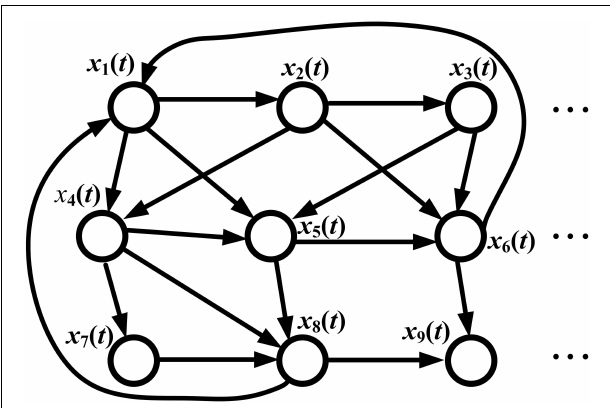
FIGURE 2 | Information flow in a GRN. x i ( t ) denotes the gene expression of the i th gene. Since the gene regulation is directional, the graph of the GRN is a directed graph (digraph). The signal processing model of the GRN is given in Equation (26) by microarray temporal data; the signal flow between any two genes is described by Equation (28) and the information transductivity can be obtained by solving Equation (30). If data are available from only one temporal sample microarray, the static state-space model in Equation (32) is used, and the information flow between any two genes is given by Equation (34), with information transductivity in Equation